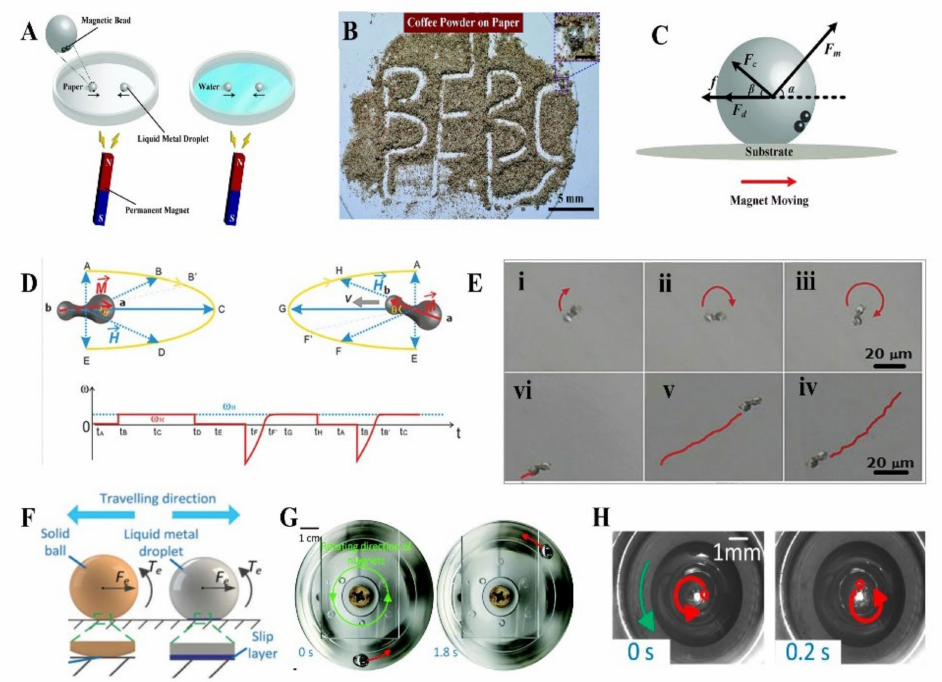
Figure 14. Magnetic field propelled MLMTs. ( A ) A schematic illustration of the directed magnetic controlled MLMTs. ( B ) The magnetically driven shuttling of MLMTs through coffee powder on a piece of printing paper. ( C ) Force diagram of magnetically driven MLMTs [99]. ( D ) A schematic illustration of the mechanism of the bowling-pin-like MLMTs in an elliptically polarized magnetic field. ( E ) Continuous captures of rotation of MLMTs under rotating magnetic ( i )–( iii ) and translational motion of MLMTs under an elliptically polarized magnetic field ( vi )–( iv ) [49]. ( F ) A schematic illustration of the actuation of a solid ball and a MLMTs placed on a substrate. ( G ) Continuous snapshots for the locomotion of a MLMTs [100]. ( H ) Time-lapse images of the self-rotation of MLMTs